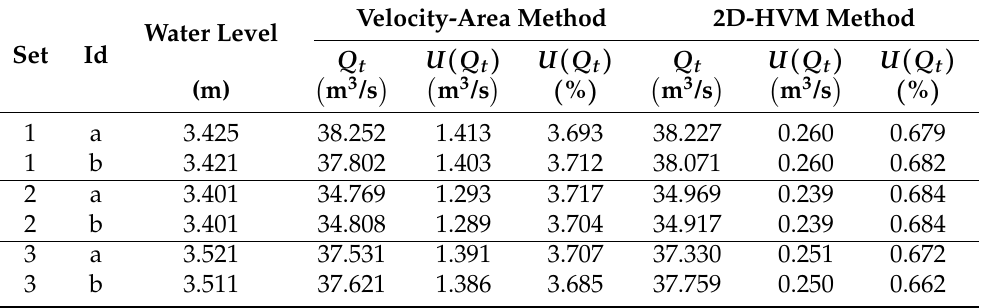
Table 2. Results for measurements of section GG11. Coverage coefficient— k = 2.